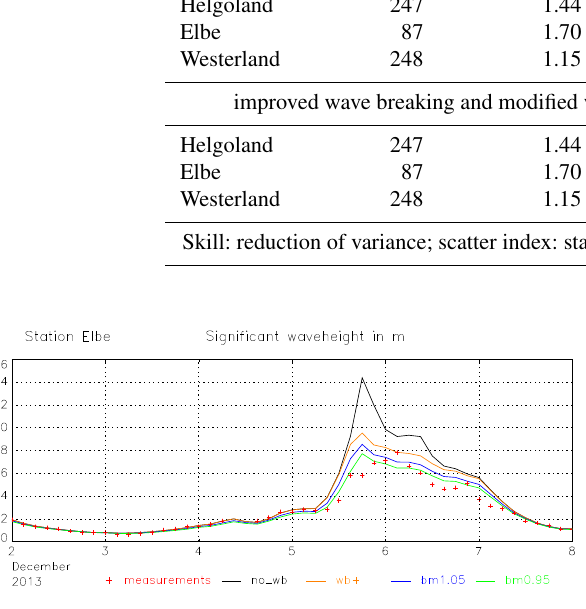
Table 3. H s statistics during storm Xavier in the German Bight. The positions of the buoys are shown in Fig. 1. Buoy Number of Mean of Bias Root mean Skill Scatter comparisons measurements square error index H s – (m) (m) (m) – (%)